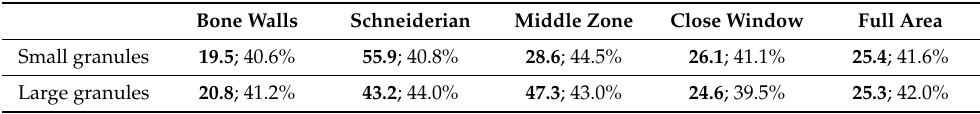
Table 4. Intersection points between newly formed bone and dense tissue. Days (in bold) and percentage of BGC are